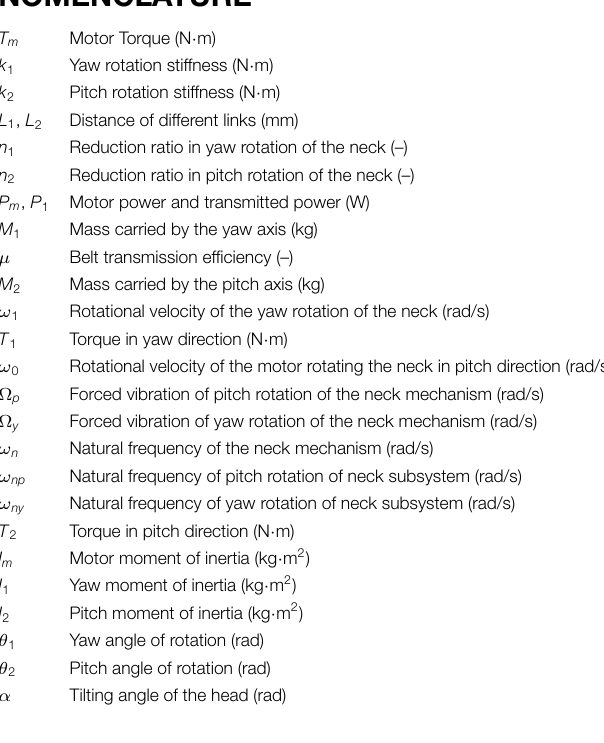
h umanoid robot and a standalone desk version. Motion